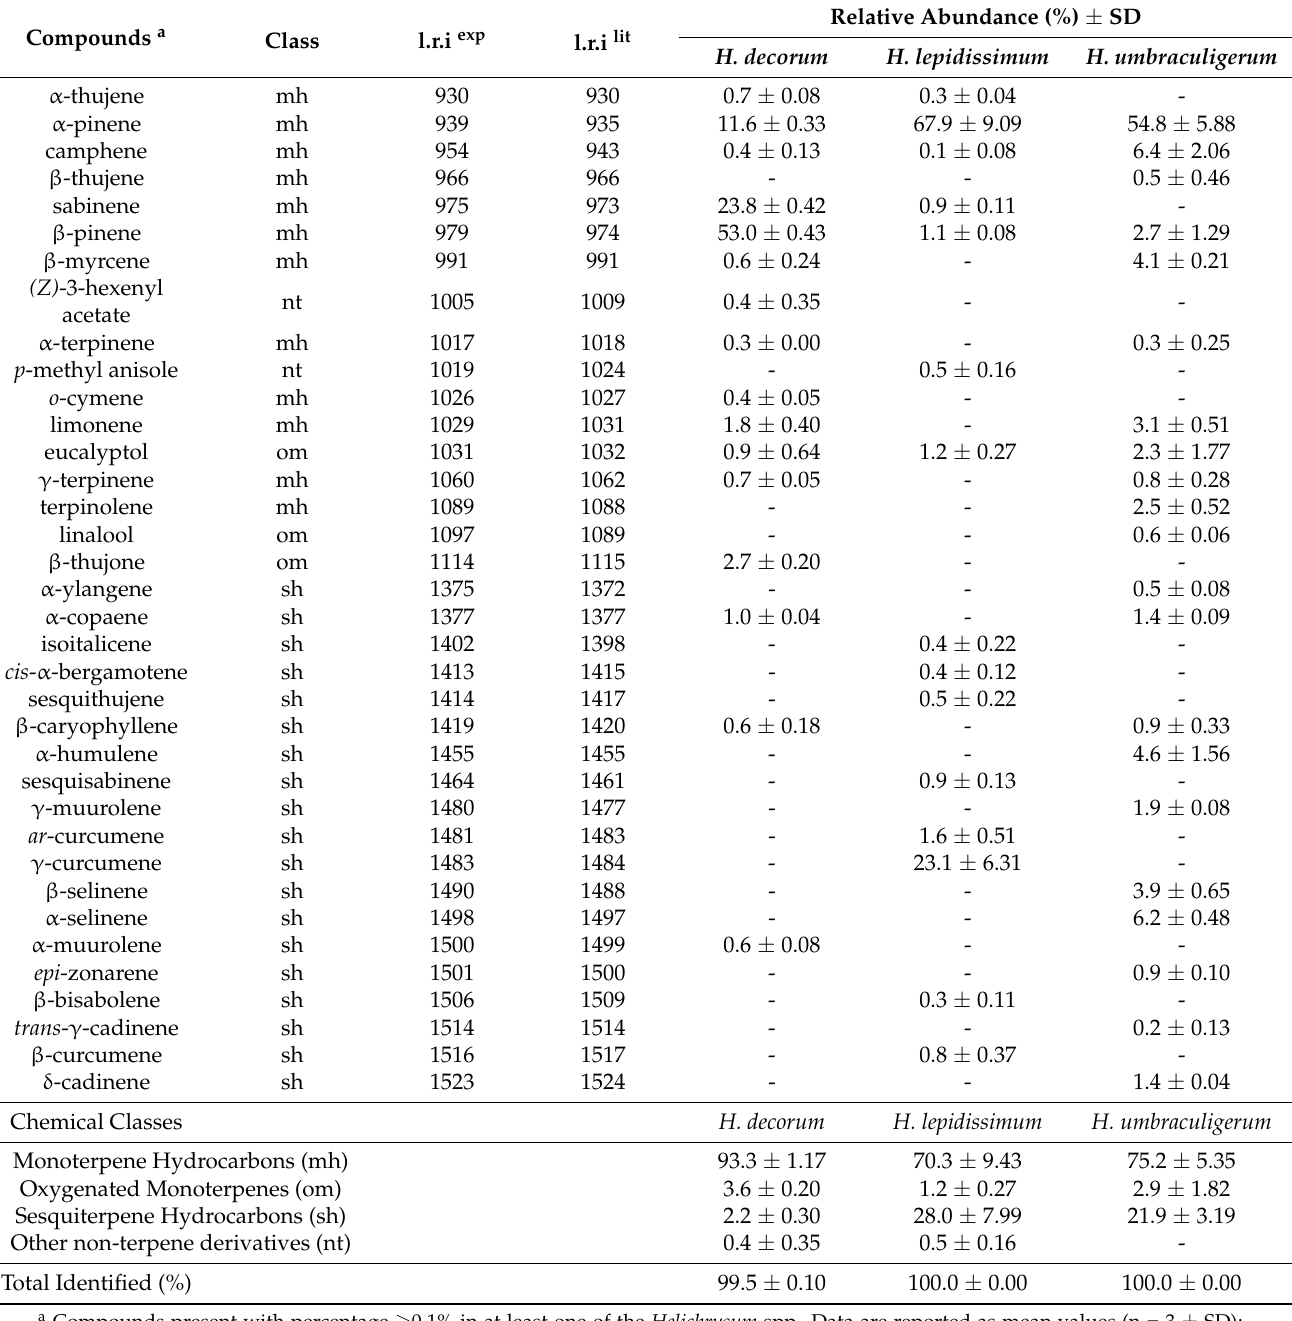
Table 1. Complete chemical composition of spontaneous emissions of three analyzed Helichrysum